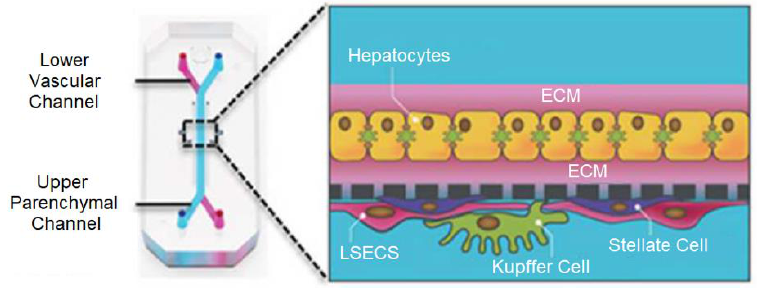
Figure 8. The cross-section of the liver-on-a-chip for simulating hepatic sinusoids [80]. Reproduced with permission from Elsevier Copyright (2023).